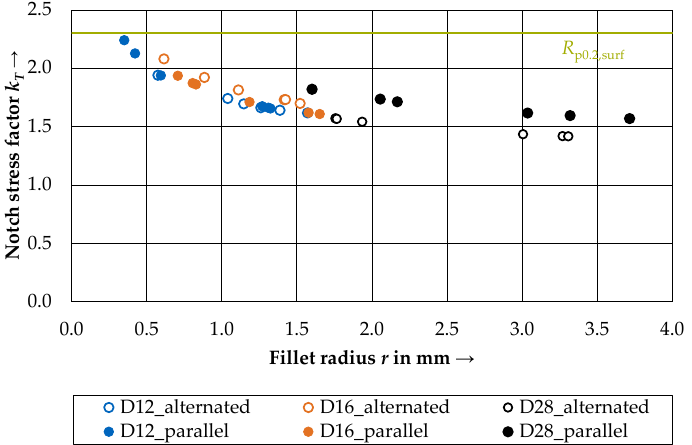
Figure 10. Maximum notch stress factors plotted over the fillet radius r for three different diameters separated into parallel and alternated rib sides .